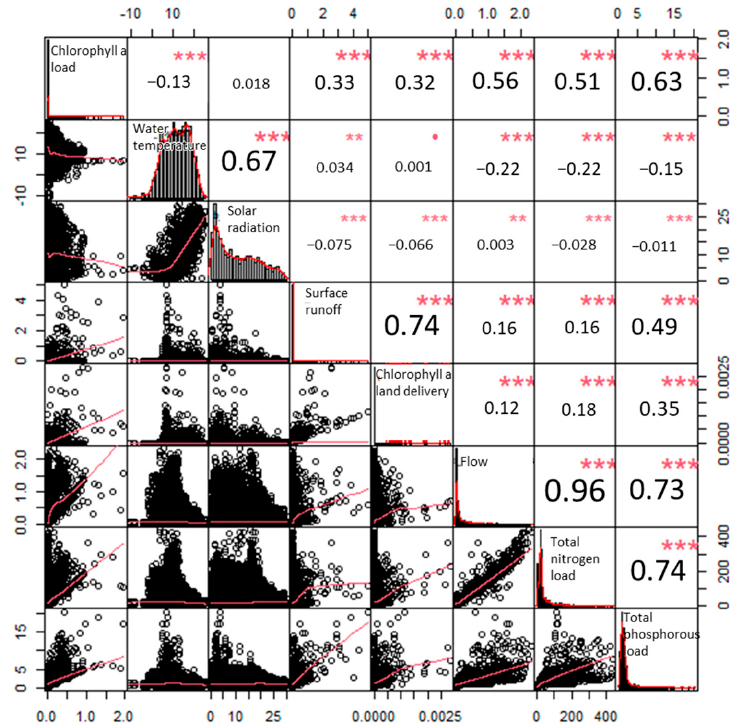
Figure 3. Correlation analysis matrix-significance level is associated with a symbol: p -value below 0.001 as “***”, between 0.001 and 0.01 as “**”, 0.05–0.1 as “ • ”, and higher than 0.1 without a symbol.